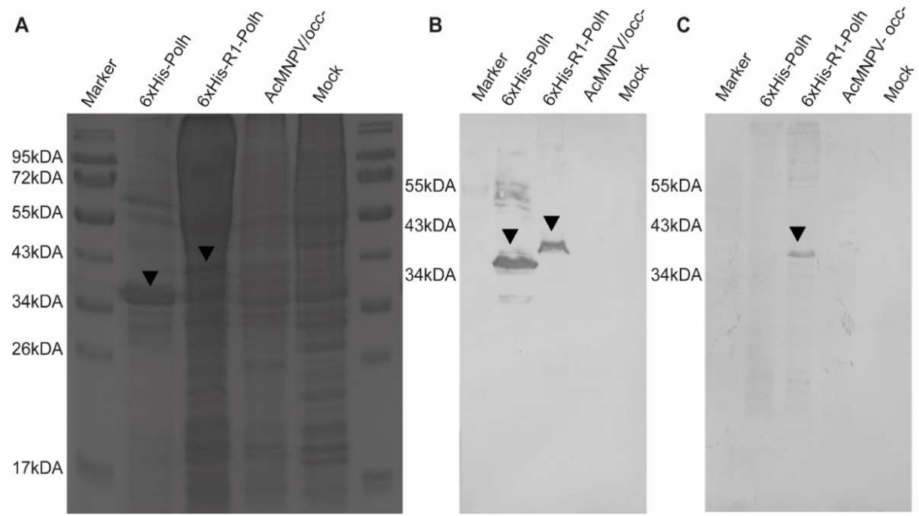
Figure 3. Protein expression analyses of the recombinant 6xHis-R1-polh in insect cells infected with different recombinant baculoviruses, including vAc-6xHis-polh, vAc-6xHis-R1-polh, and AcMNPV/occ- (without polh expression). ( A ) SDS-PAGE of insect cells extracts infected with differ- ent recombinant baculoviruses; ( B , C ) Membranes immune-stained with ( B ) anti-6xHis (Promega), ( C ) anti-CHIKV-positive patient’s serum as primary antibodies, incubated with mouse and human anti-IgG, respectively, and conjugated to alkaline phosphatase enzyme (Invitrogen). The proteins’ reacting bands were detected using the substrate NBT/BCIP (Promega). Black arrowheads point the specified